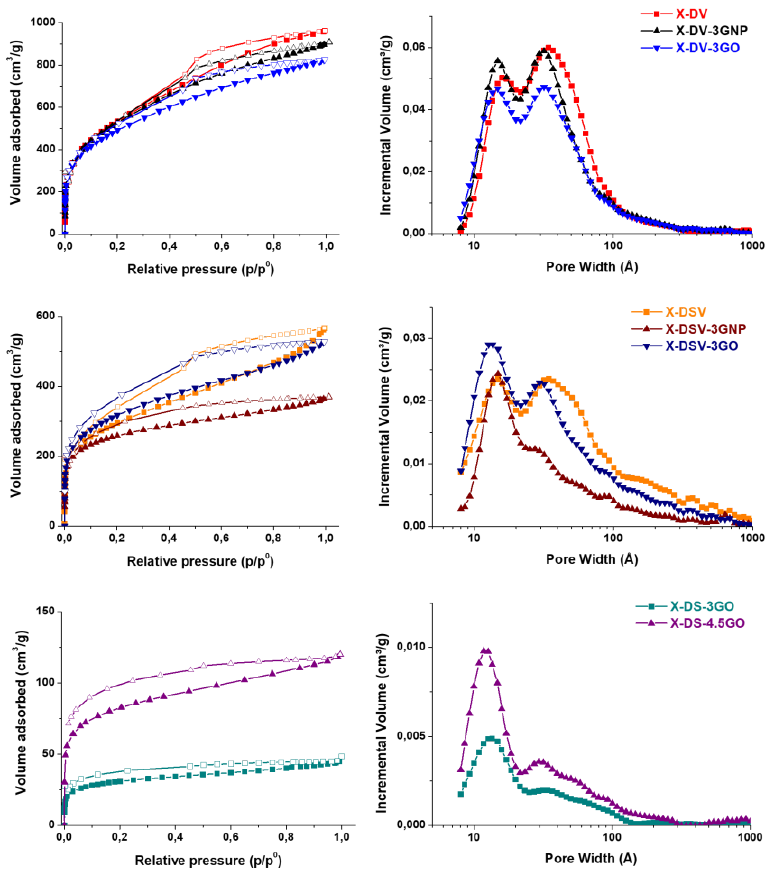
Figure 9. Isotherms of adsorptions (left) and density functional theory pore size distributions (right) of the DVB/VBC, DVB/ST/VBC and DVB/ST systems. The DVB/VBC based hyper-crosslinked polymer (HCP) is coded X-DV, the DVB/ST/VBC based HCP is coded X-DSV and the DVB/ST based HCP is coded X-DS. The nanocomposites containing graphene nanoplatelets (GNP) or surface modified graphene oxide (GO) are coded as the corresponding polymeric samples adding a suffix indicating the amount (phr) and the type of nanofiller. Reprinted with permission from [34]. Copyright 2017 American Chemical Society (Washington, United States of America).